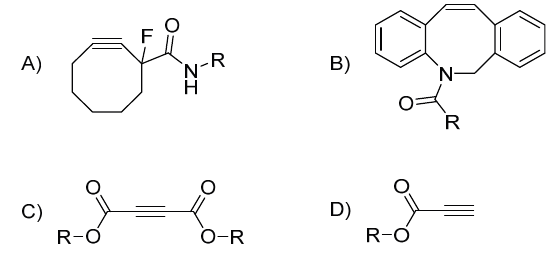
Figure 3. Copper-free synthons used in dendrimer synthesis ( A ) fluorinated cyclooctyne ( B ) a dibenzoazocyclooctyne variant ( C ) acetylenediesters ( D ) propiolic